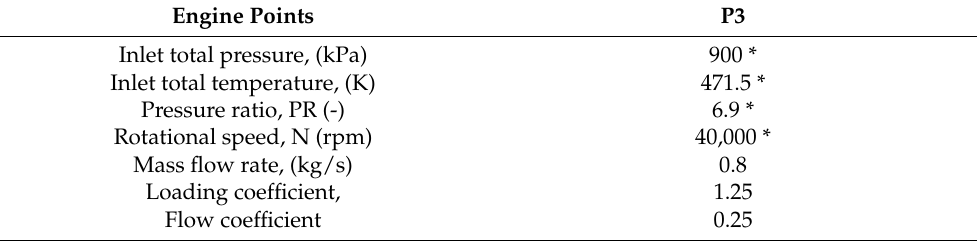
Table 1. Mean-line and computational fluid dynamics (CFD) input conditions.